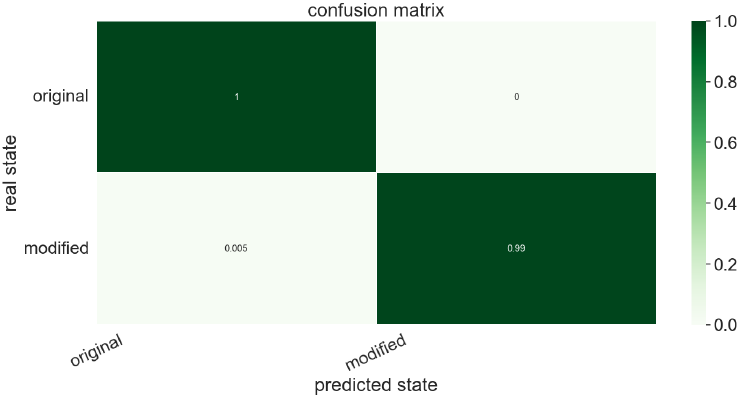
Figure 9. Confusion matrix related to the profiles of the three composite sheets.